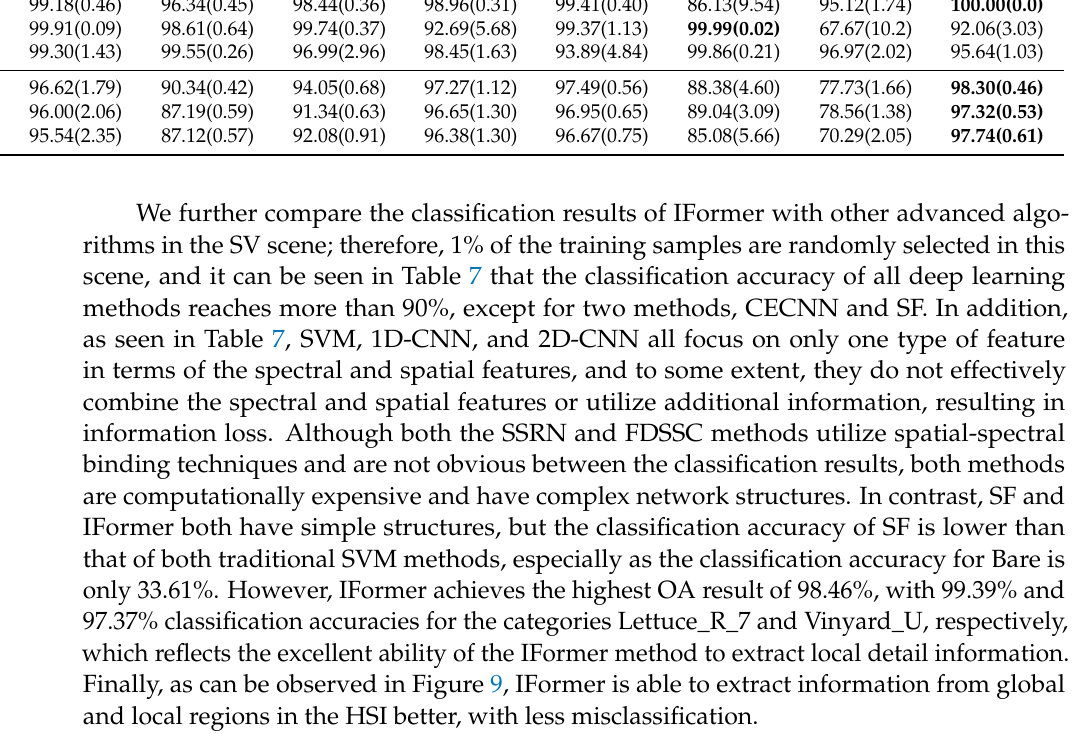
Table 7. Accuracy comparison of different methods on SV